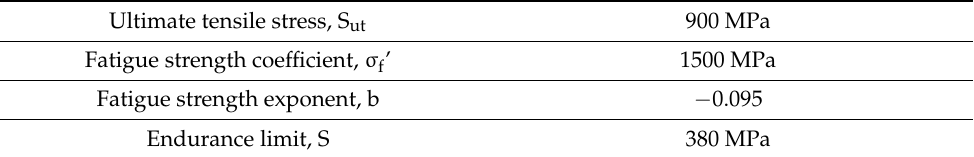
Table 4. Fatigue properties of Ti-6Al-4V